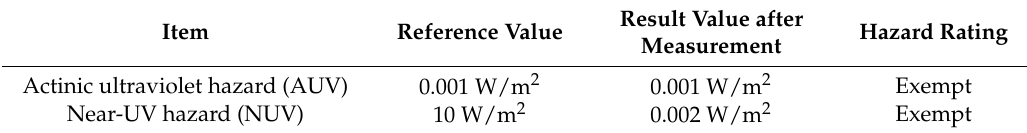
Table 5. Comparison of the IEC 62471 standard and UV general lighting measurement